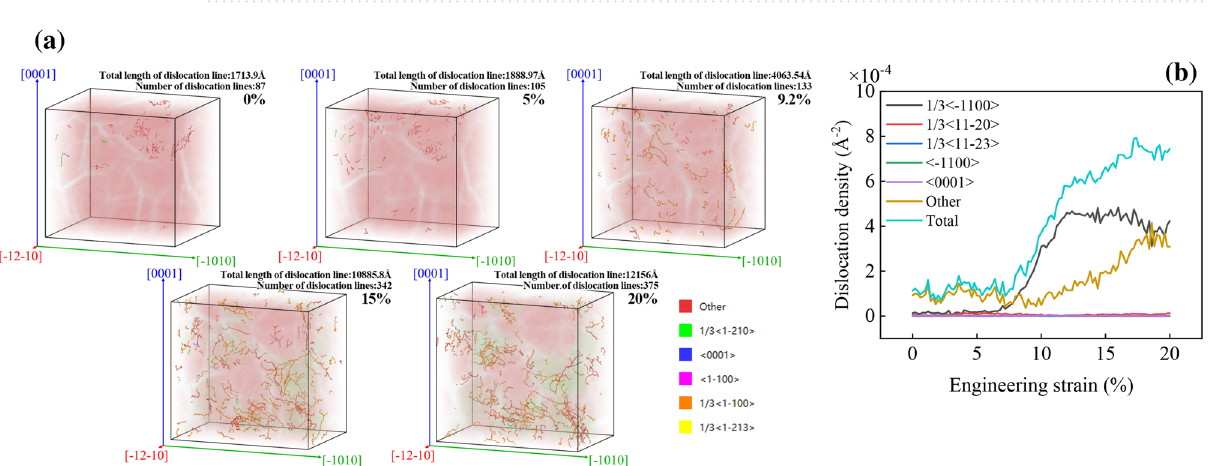
1210 . (cid:31) (cid:30)